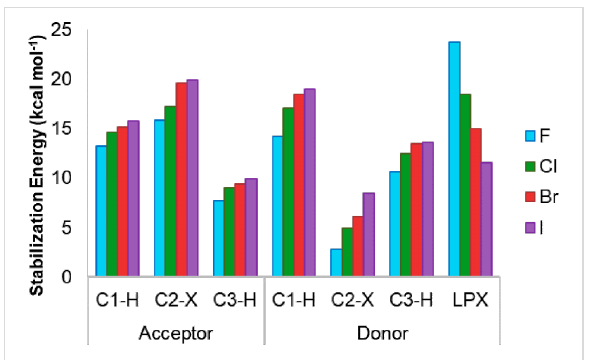
Figure 7: Sum of bonding (donor) and antibonding (acceptor) orbitals interactions of C1–H, C2–X and C3–H ax bonds and LP X in cis -2-halo- cyclohexylamines.